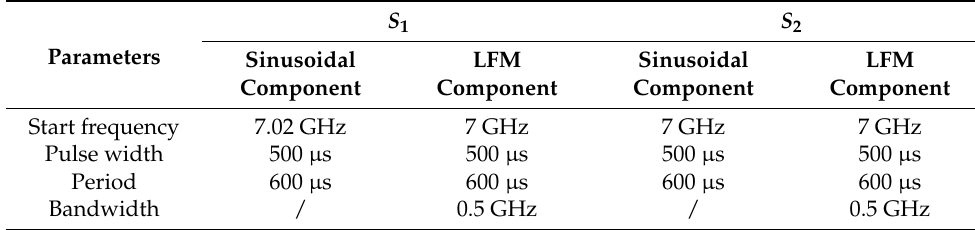
Table 1. Parameters of two composite signals.